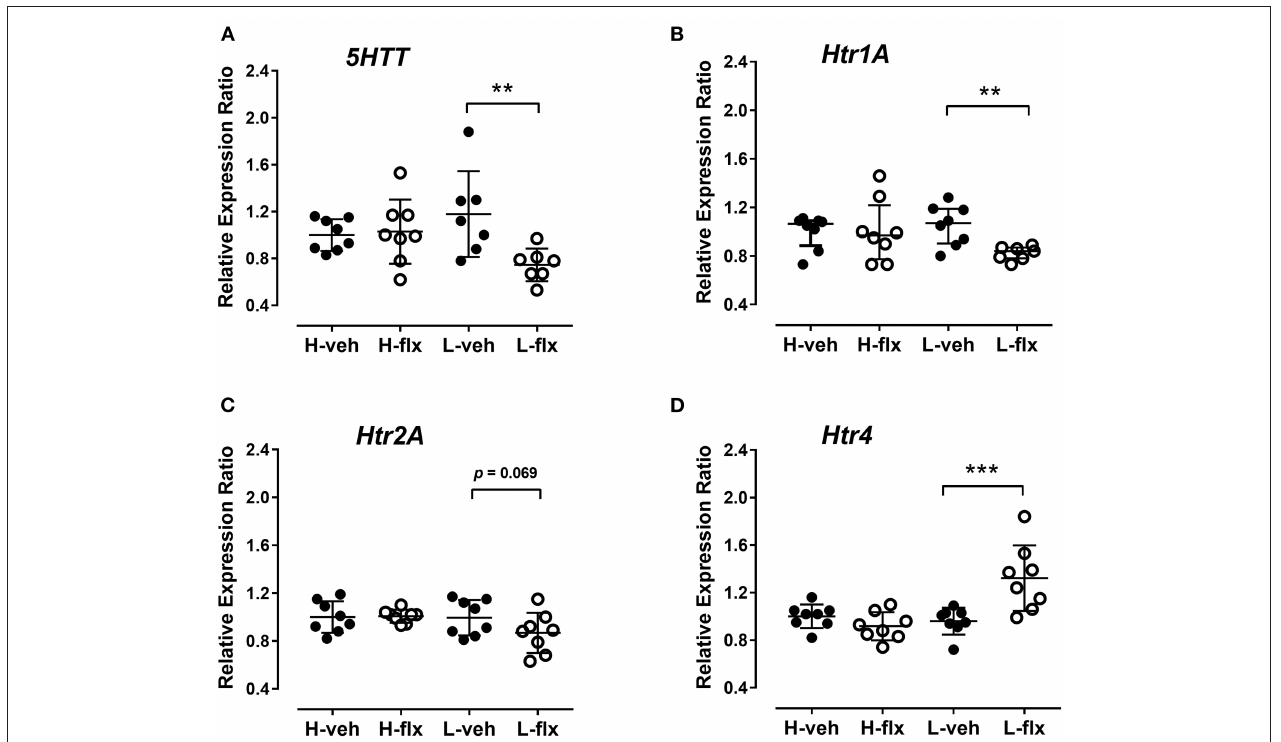
FIGURE 7 | Effects of fluoxetine on cortical expression levels of serotonin-regulating genes. (A) Serotonin transporter [ F 3, 26 = 3.747, p = 0.0232, 1w-ANOVA], (B) 5HT receptor subtype 1a (KW = 7.93, p = 0.0475, Kruskal-Wallis test), (C) 5HT receptor subtype 2a [ F 3, 28 = 2.003, n.s., p = 0.136, 1w-ANOVA] and (D) 5HT receptor subtype 4 [ F 3, 28 = 9.59, p = 0.0002, 1w-ANOVA]. Cortical tissue was harvested 48h after the 27th injection of vehicle or fluoxetine. Expression levels are normalized to the mean of two reference genes, glyceraldehyde-3-phosphate dehydrogenase and actin beta. Data from individual animals are shown and group means ± SD (A,C,D) or group medians and IQR (B) are indicated ( n = 7–8 per group). p -values obtained with Fisher’s LSD (following 1w-ANOVA) or Dunn’s test (following KW) are given. H , high-5HT animals; L, low-5HT animals; veh, vehicle; flx, fluoxetine. ** p < 0.01 and *** p <